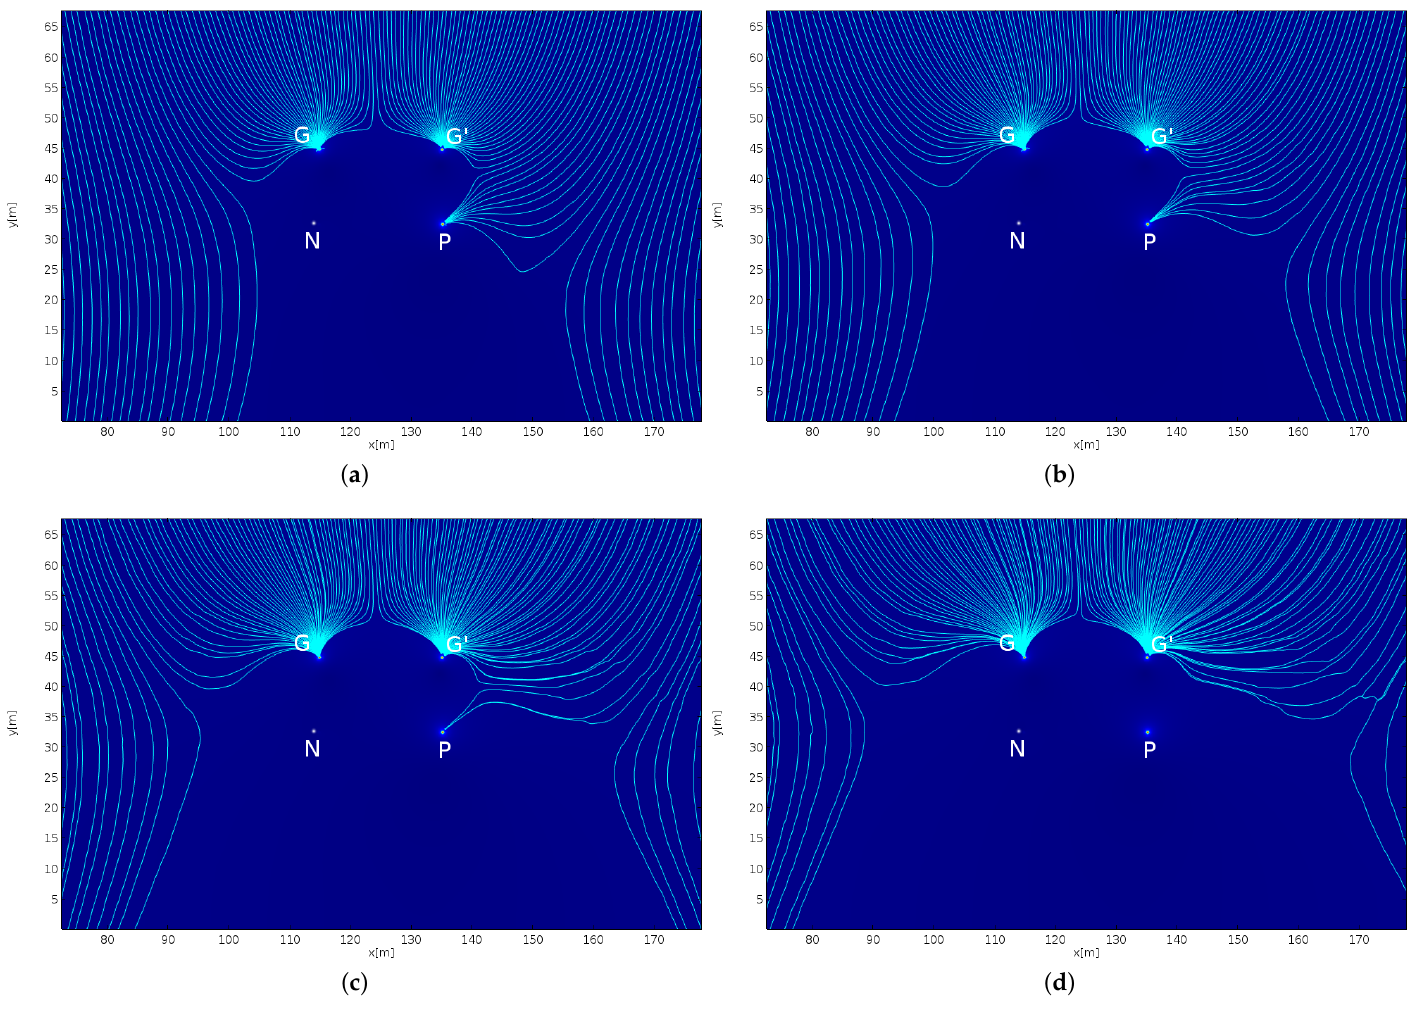
Figure 11. Lightning incidence in the span region as given by EFD model. ( a ) I p = 2.9 kA, ( b ) 5.4 kA, ( c ) 10.1 kA and ( d ) 15.7